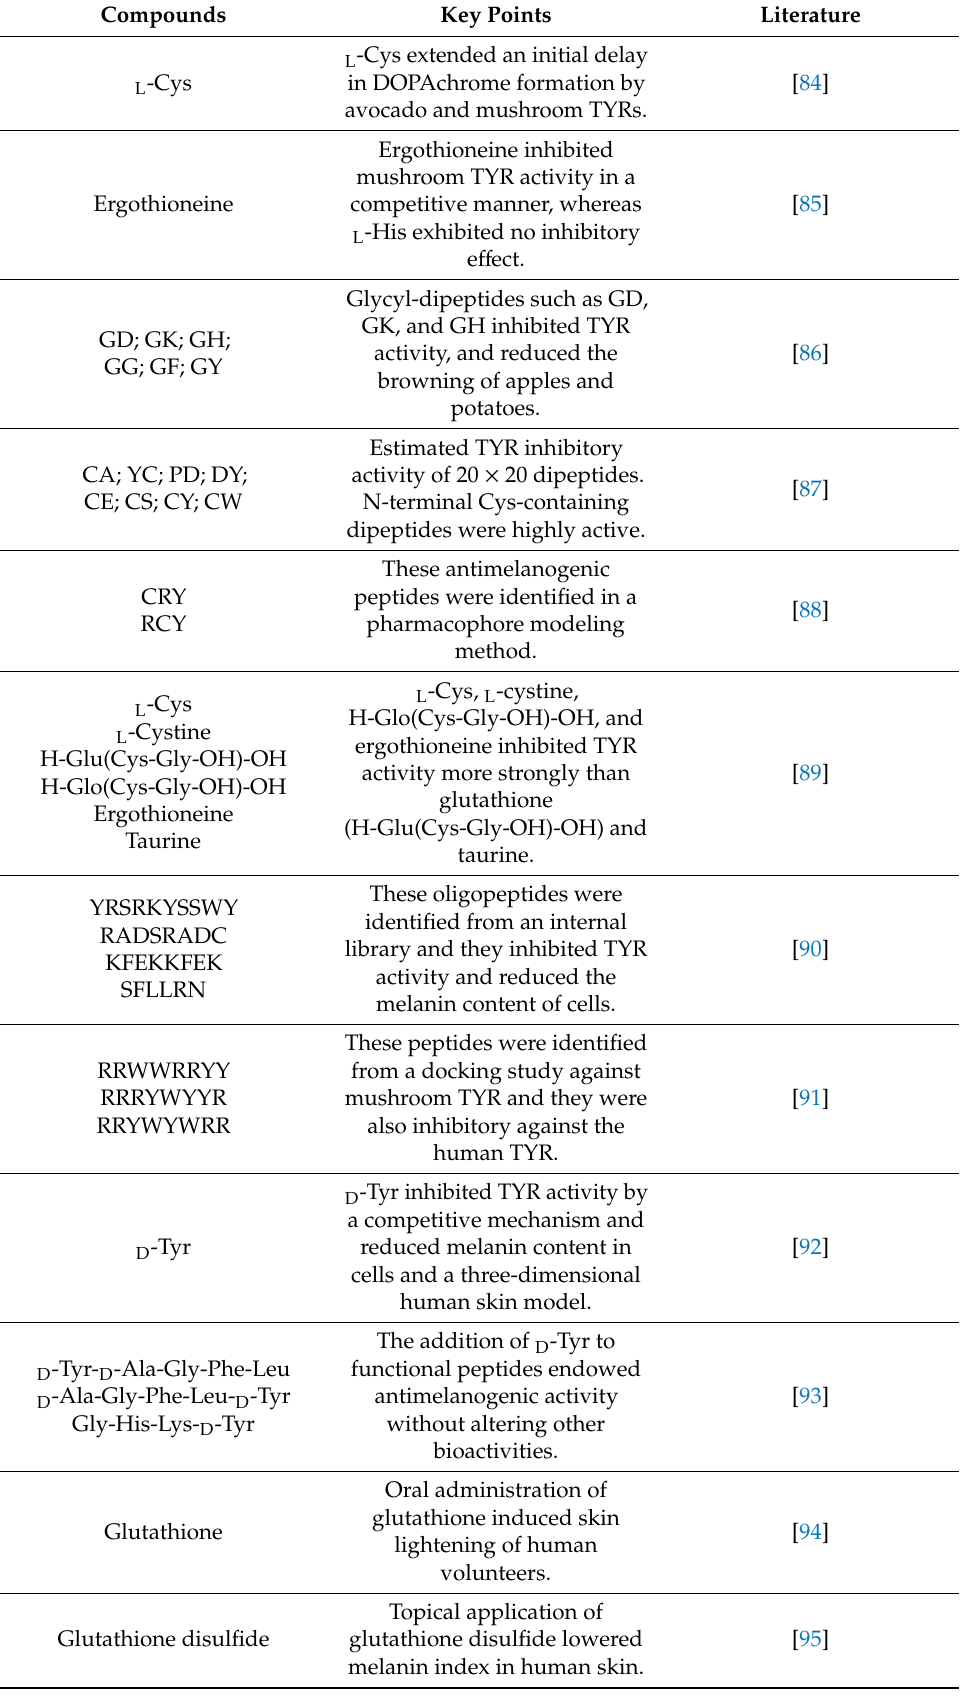
Table 2. Amino acids, peptides, and their analogs that inhibit TYR activity and melanin synthesis.